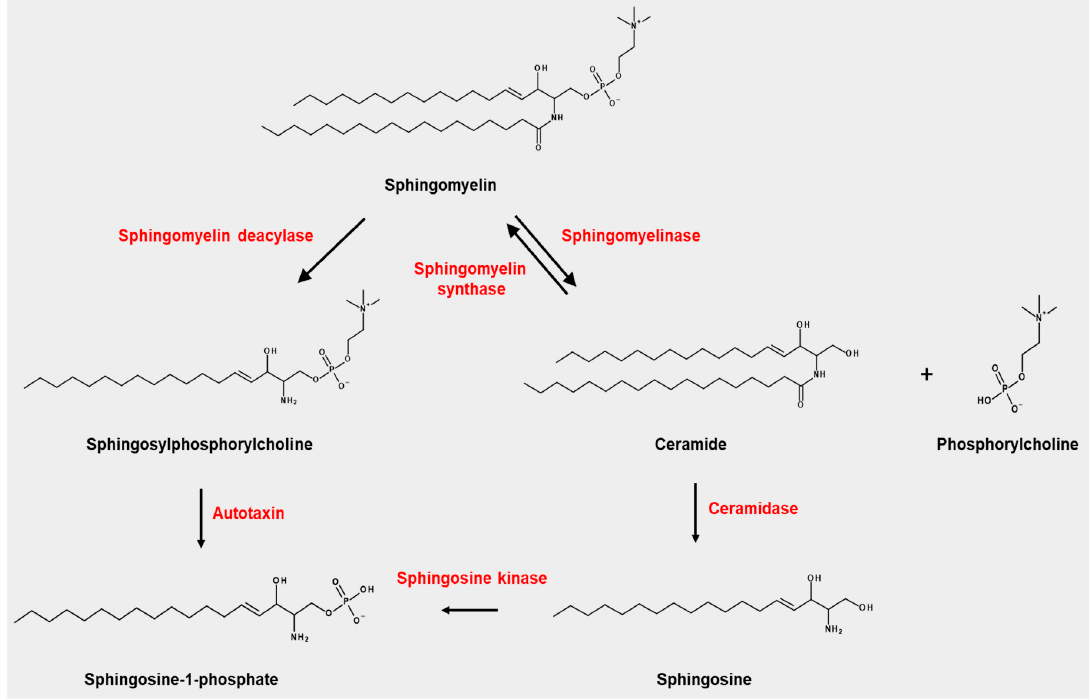
Figure 1. Occurrence of sphingosylphosphorylcholine (SPC) and its related